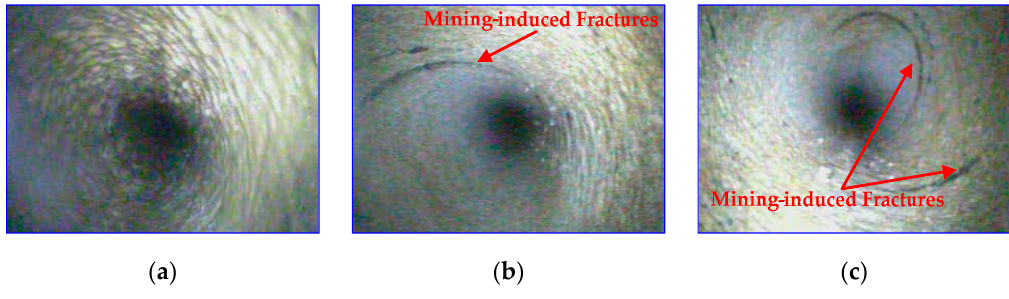
Figure 13. Images of the overburden around #2 characteristic point: ( a ) 100 m from the coalface; ( b ) 30 m from the coalface; ( c ) 20 m from the coalface.